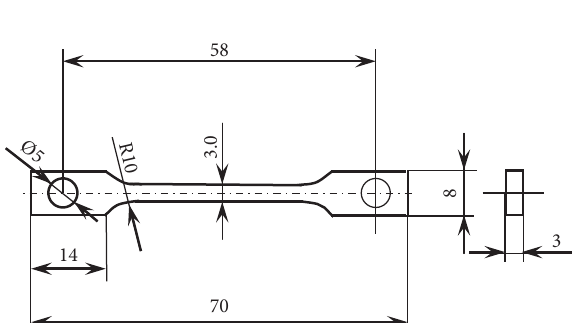
are given in Tables 5–9. The presented tables show the results value of the strain + ε i and negative − ε i depending on the applied normal stress σ . Also the calculated values char- i acterizing the inhomogeneity of the microplastic deforma- tion of the samples deposited by the electrocontact method are shown—the standard deviation S (respectively, according to the total microplastic deformation S , positive 1 S and negative S ) and the deformation coefficient 2 3 according to the total deformation c , the positive defor- 1 mation c , and negative one– c . 2 3